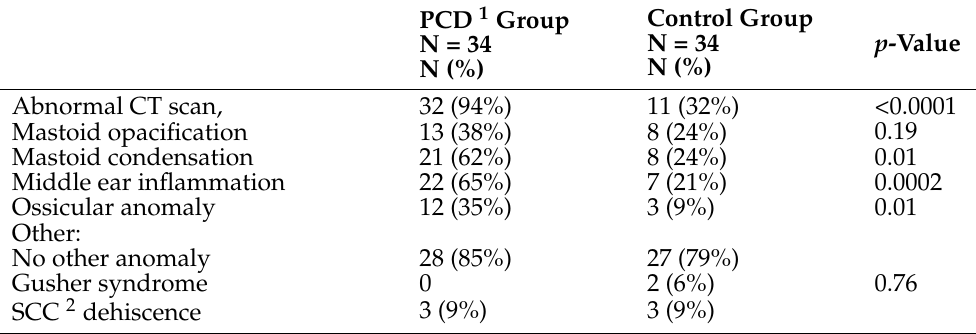
Figure 2. Right temporal bone CT scans in axial view showing (white arrowheads) ( a ) a normal round window (control patient) and ( b ) a filling of the round window (PCD patient).